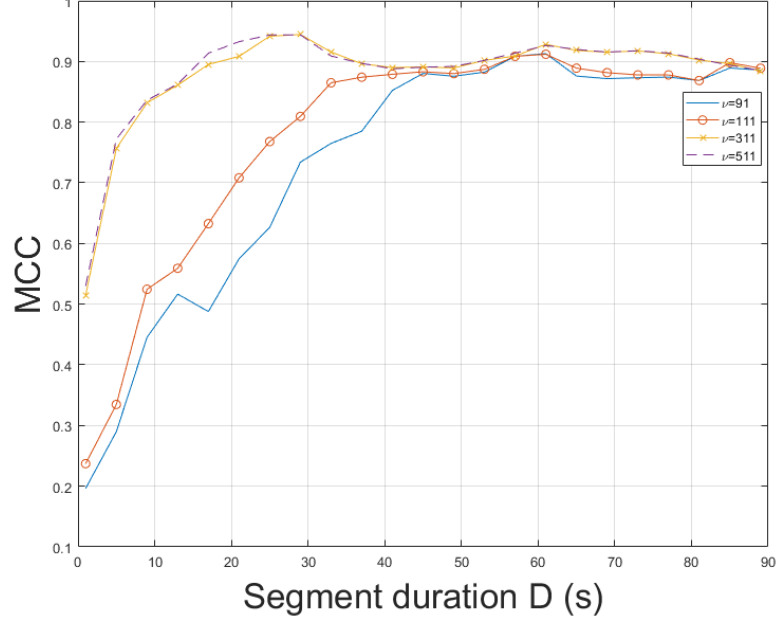
Figure 11. Maximum correlation coefficient of the proposed approach employing SLIC+STFT for various bandpass filter orders and segment durations